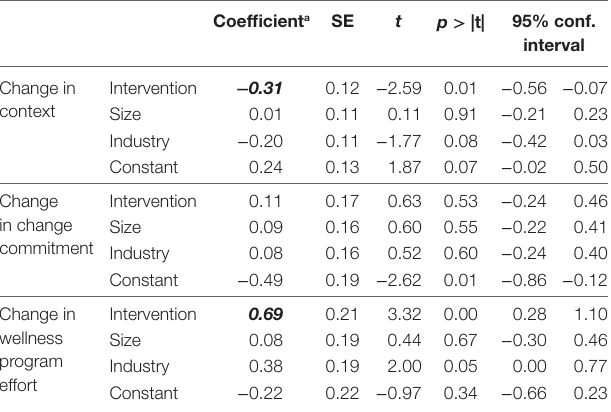
Table 6 | Regression model results for differences between intervention and control sites in change from baseline to 15 months in context, change commitment and wellness program effort.